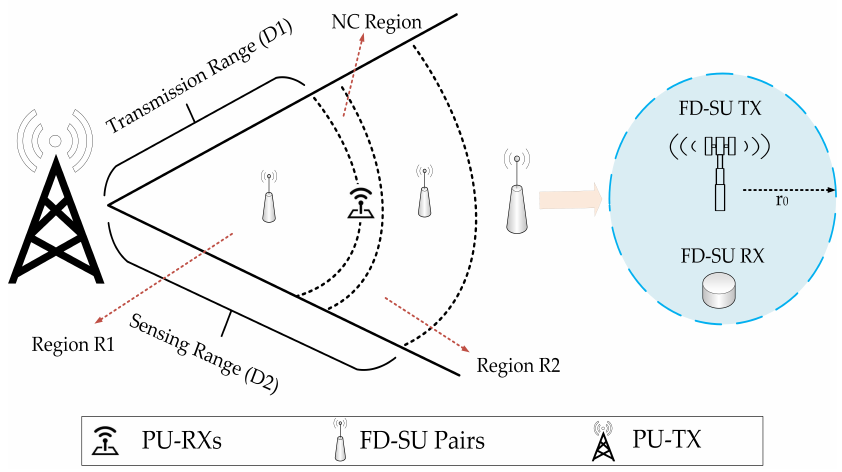
Figure 5. Considered cases of FD-SU